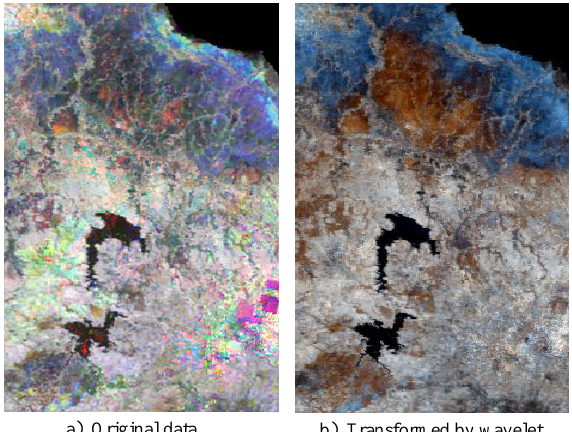
Figure 3. The result of filtering on MODIS image.